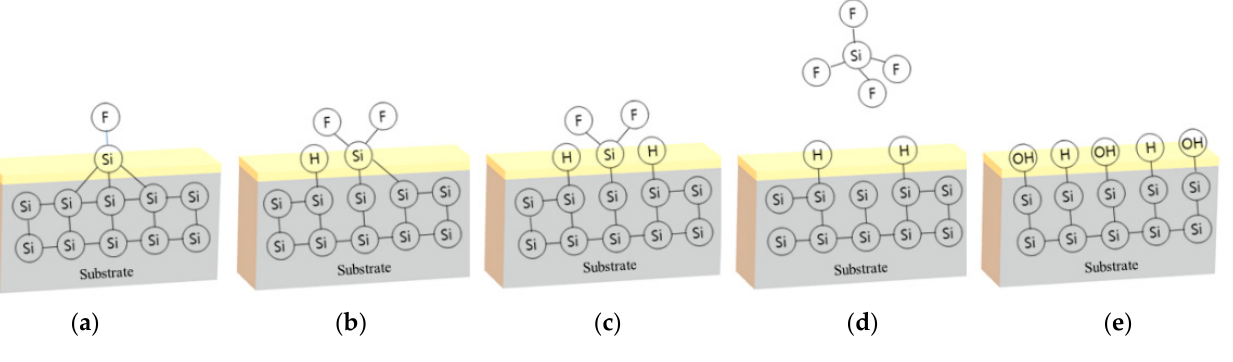
Figure 6. Initial oxide removal and H, OH-terminated silicon surface characteristics: ( a ) F-termination state of silicon surface ( b , c ) Breaking of Si–Si bonds by hydrogen ( d ) H-termination state of silicon surface ( e ) Final state of silicon surface